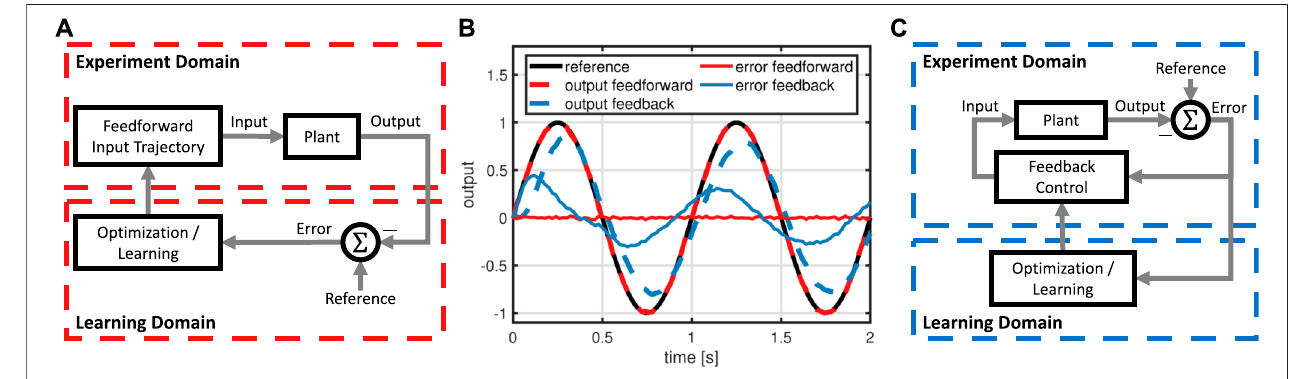
FIGURE2| Comparison offeedforward (A) and feedbacklearningcontrol (C) forreferencetrackingwithasystemaffectedbyinputdelayandmeasurementnoise: Feedforward, unlike feedback control, achieves almost perfect tracking (B) . Hence, the learning method proposed in this work employs feedforward control.